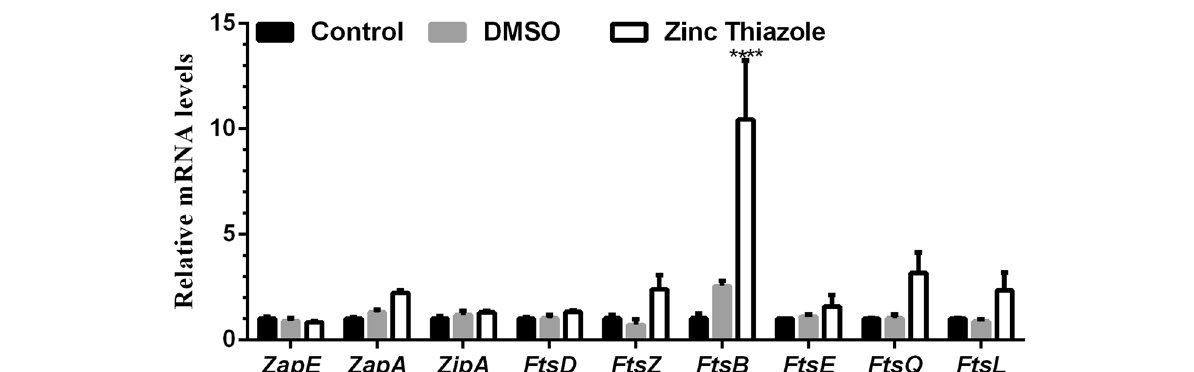
Fig. 4 qRT-PCR analysis of the mRNA expressions of cell-division-related genes in zinc thiazole-treated Xoo . PXO99 cultures were treated with zinc thiazole (20 μ g/mL) in DMSO (0.125%) and DMSO (0.125%), respectively. Control indicates cell suspension of PXO99 (0 μ g/mL zinc thiazole without DMSO). All groups were harvested at OD 600 = 1.0. The total RNA of Xoo was extracted, and the relative gene expressions were quantified by qRT-PCR. The relative transcription levels were normalized to that of RecA . Error bars represent standard errors from three independent replicates. ****: P < 0.0001